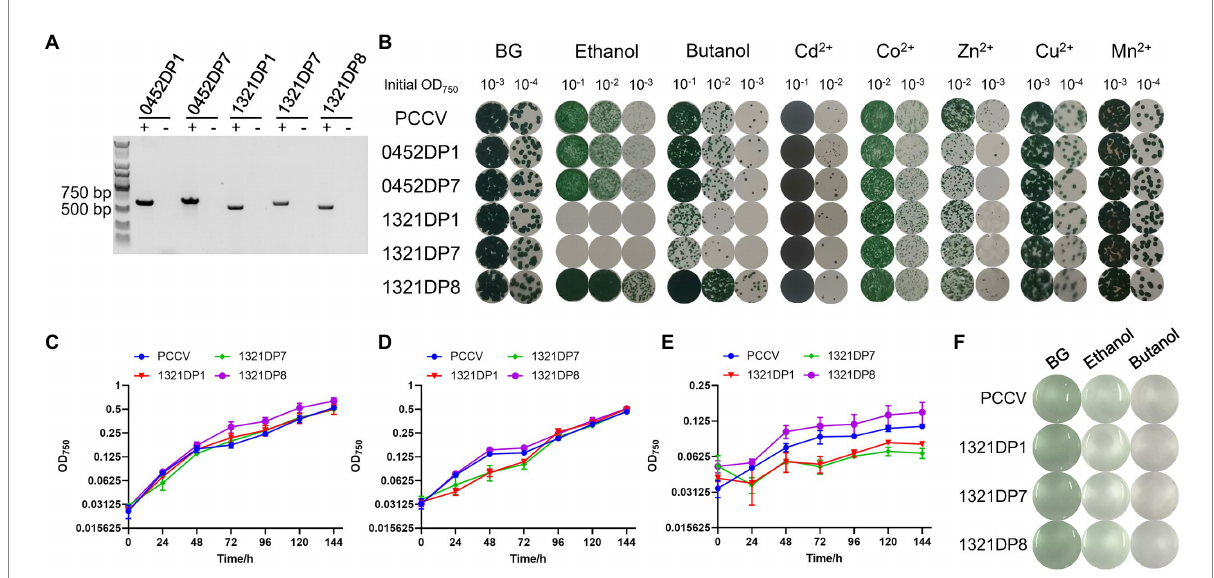
FIGURE 1 Construction and characterization of the DP mutants. (A) Validation of the five DP mutants by PCR. The expected amplicon size: 652 bp (0452DP1), 714 bp (0452DP7), 597 bp (1321DP1), 659 bp (1321DP7), and 585 bp (1321DP8). The symbol “+” means using the corresponding DP mutants as templates, while the symbol “ − ” means using PCCV as negative control. (B) Assays of the PCCV and the five DP mutants under different stress conditions on agar plates. Cultures were adjusted to different concentrations and cultivated on agar plates with different stress conditions. (C) Growth curves of PCCV, 1321DP1, 1321DP7, and 1321DP8 in normal BG-11 medium. (D) Growth curves of PCCV, 1321DP1, 1321DP7, and 1321DP8 in normal BG-11 medium with 1.5% (v/v) ethanol. (E) Growth curves of PCCV, 1321DP1, 1321DP7, and 1321DP8 in normal BG-11 medium with 0.25% (v/v) 1-butanol. (F) PCCV, 1321DP1, 1321DP7, and 1321DP8 in normal BG-11 medium, with 1.5% (v/v) ethanol, and 0.25% (v/v) 1-butanol after 48 h cultivation. The error bar represents the calculated standard deviation of the measurements of three biological